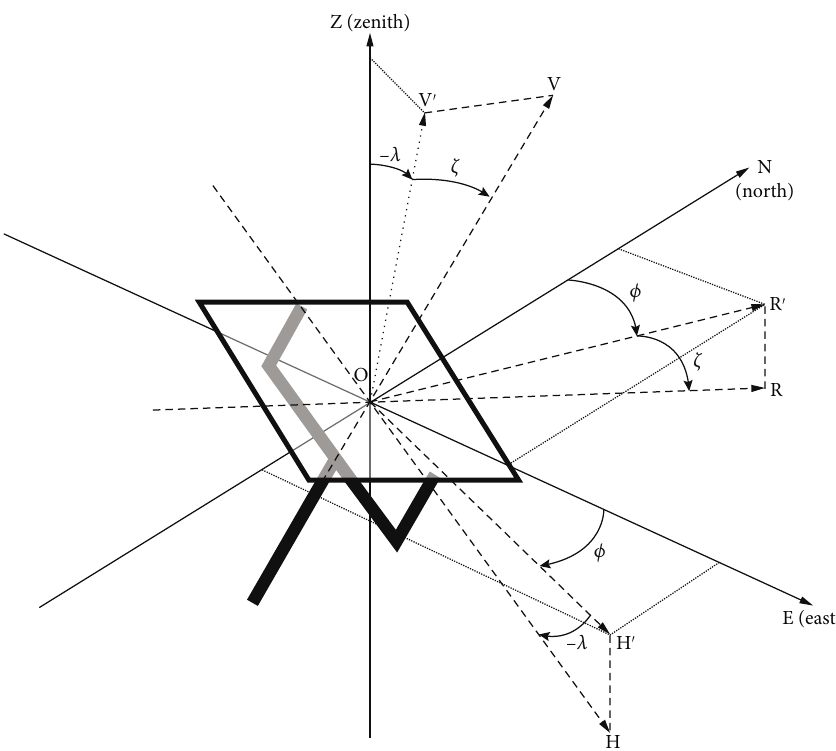
Figure 2: Three orientation angles of the mobile sun-tracking system on the moving vehicle, which subject to the change with time as the vehicle changes direction or passes speed